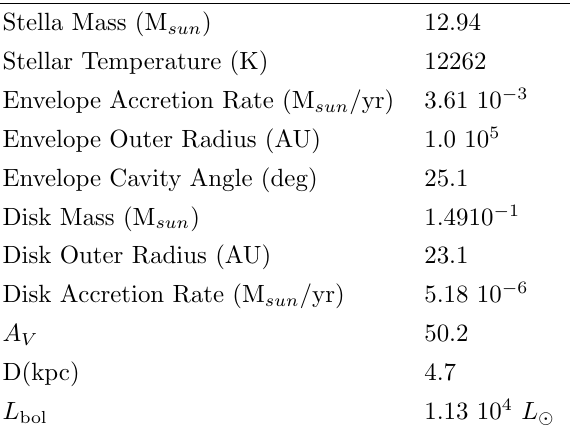
Figure 5: ( Left panel) H 2 narrow-band image of IRAS 19388+2357. ( Right panel) Narrow-band Kc image of the same region. North is at the top and east to the left. Table 2: Physical parameters of Mol 110 derived from the Robitaille et al. (2007)